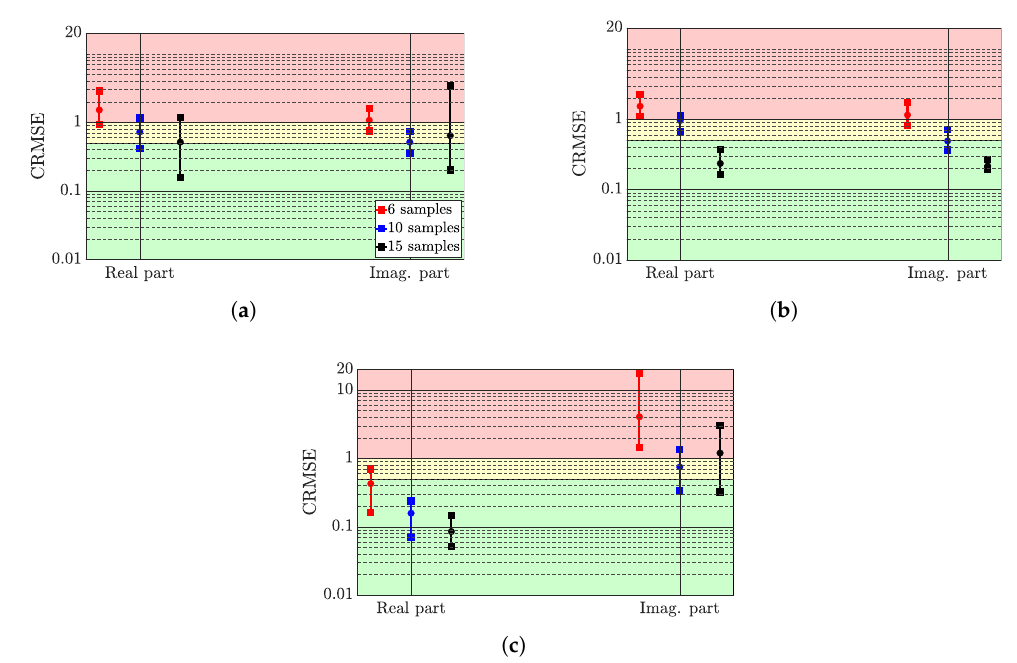
Figure 9. CRMSE range of variations for the worst hyperparameter setting of the three considered surrogate models. ( a ) Gaussian process, ( b ) deep Gaussian process, ( c ) deep neural network.